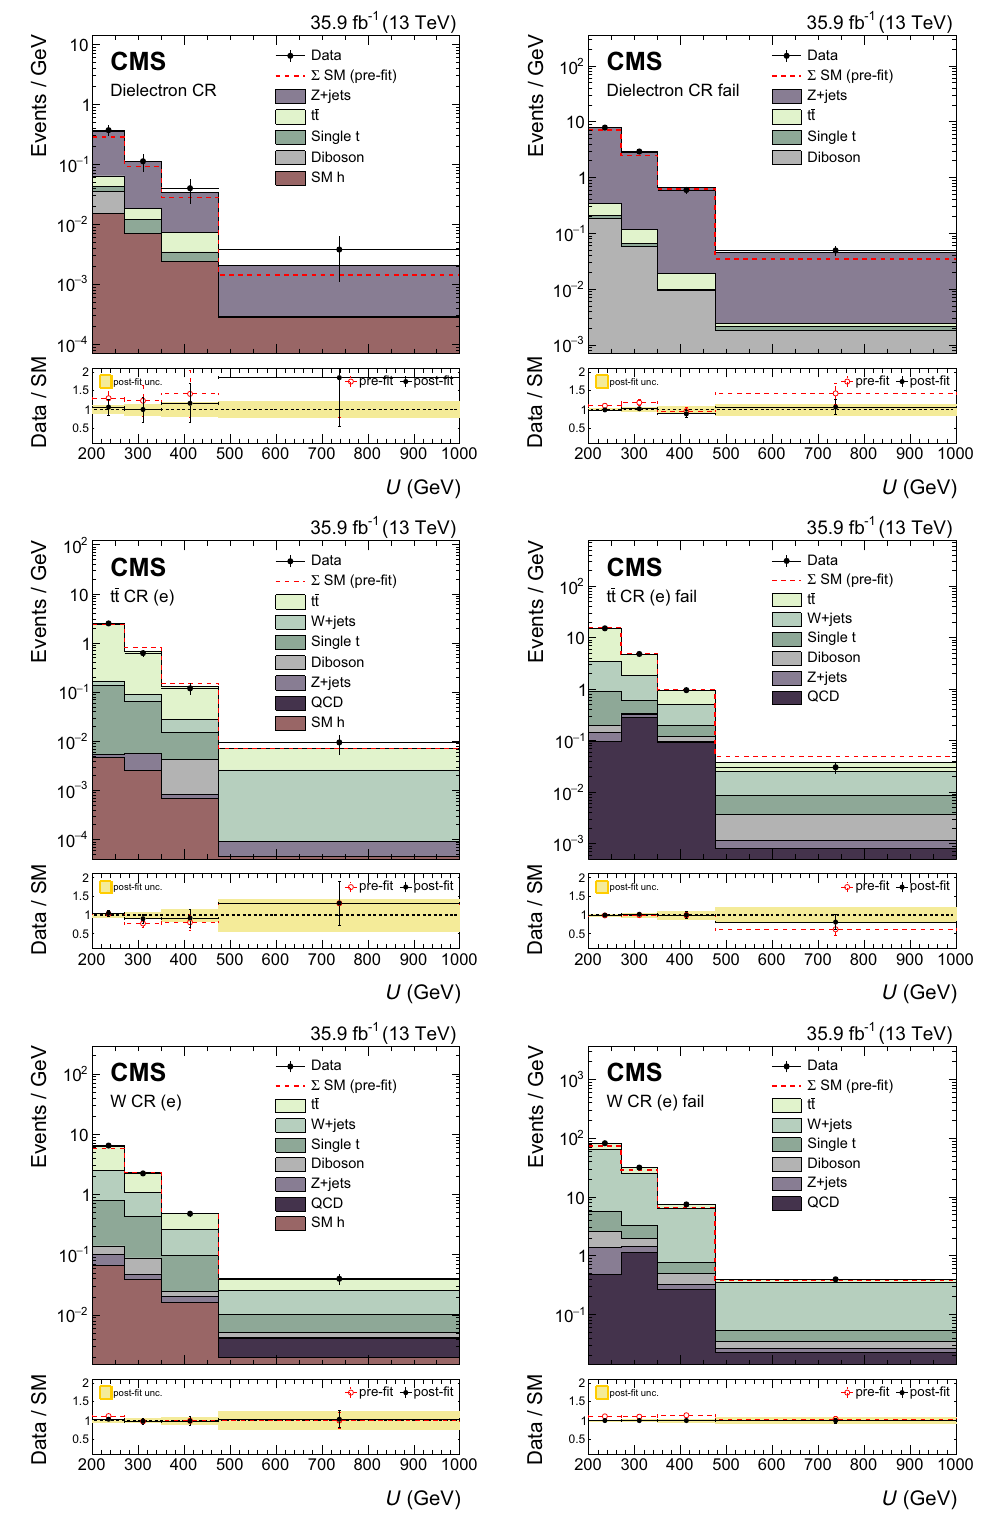
Fig. 4 The U distribution in the electron control regions before and afterabackground-onlyfittodata,includingthedatainthesignalregion in the likelihood. For the distributions on the left the CA15 jet passes the double-b tag requirement and for the distributions on the right it